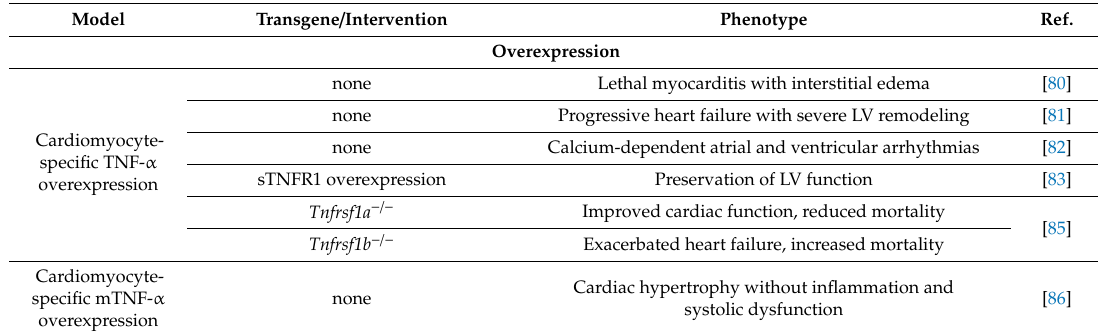
Table 2. Summary of phenotypes observed in animal models of cardiovascular diseases in relation to modification of the TNF- α signaling